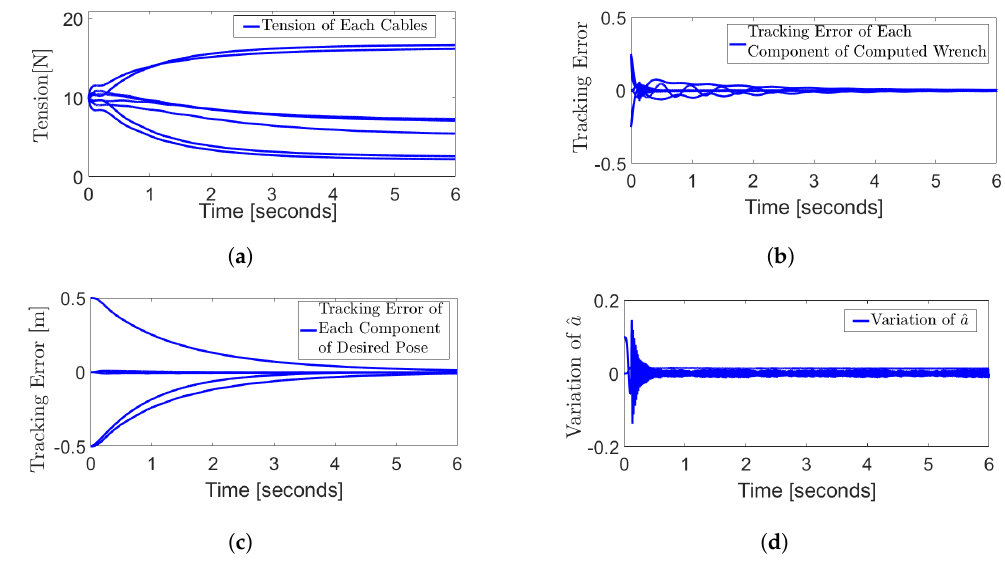
Figure 6. Results of Simulation 3. Parameters and desired pose are selected as α 1 = 15, α 2 = 12, K d = 0.1, D d = 0.1, K i = 0, Γ = 20, q d = [ 0.6, − 0.6,0.6, 0,0,0 ] T . ( a ) Tension distribution. ( b ) Tracking error of computed wrench. ( c ) Tracking error of desired pose. ( d ) Variation of ˆ a